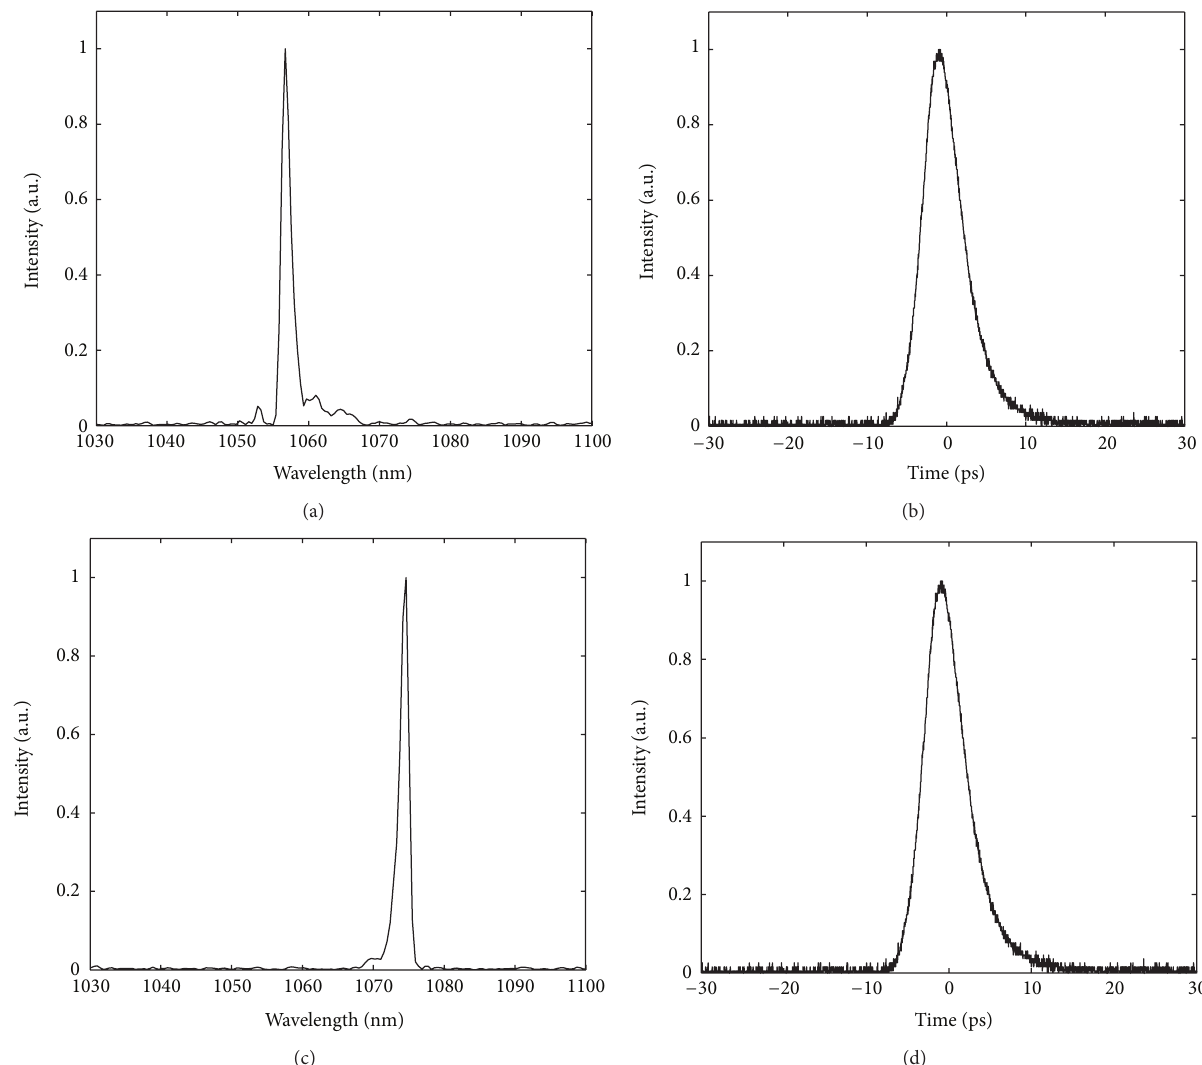
Figure 8: Characteristics of the output pulses after filtering. (a) and (b) Optical spectrum and autocorrelation trace of the pulses with the light around 1074 nm are filtered out. (c) and (d) Optical spectrum and autocorrelation trace of the pulses with the light around 1056.8 nm are filtered